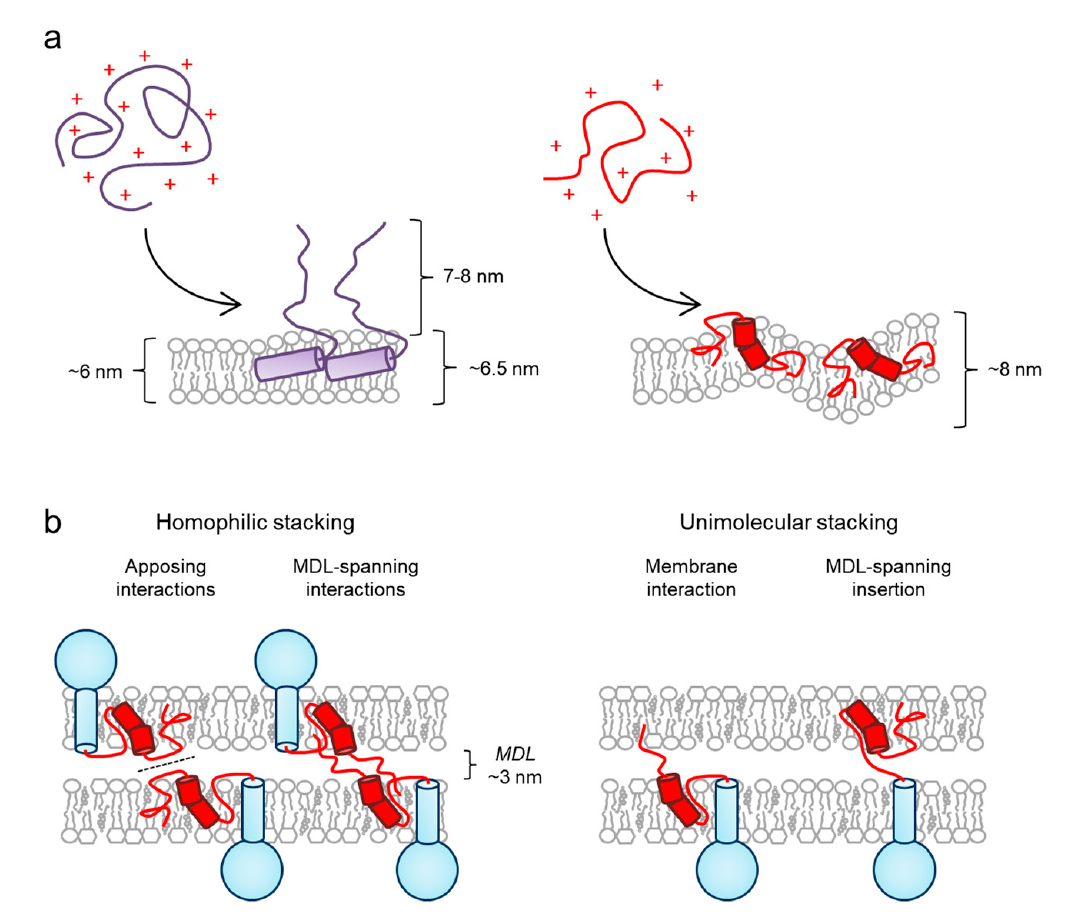
Figure 3. Hypothetical membrane stacking architecture of P0ct in the MDL. ( a ) The association of the positively charged MBP (purple; left) and P0ct (red; right) with a single phospholipid bilayer is different, as shown using model systems employing simple lipid mixtures: P0ct fully embeds into a membrane, and by doing so promotes membrane undulation and the liquid-disordered phase [44,63]. ( b ) Possible arrangements of P0ct and two apposing bilayers in a membrane stack. P0ct is drawn in red with the rest of P0 in blue.